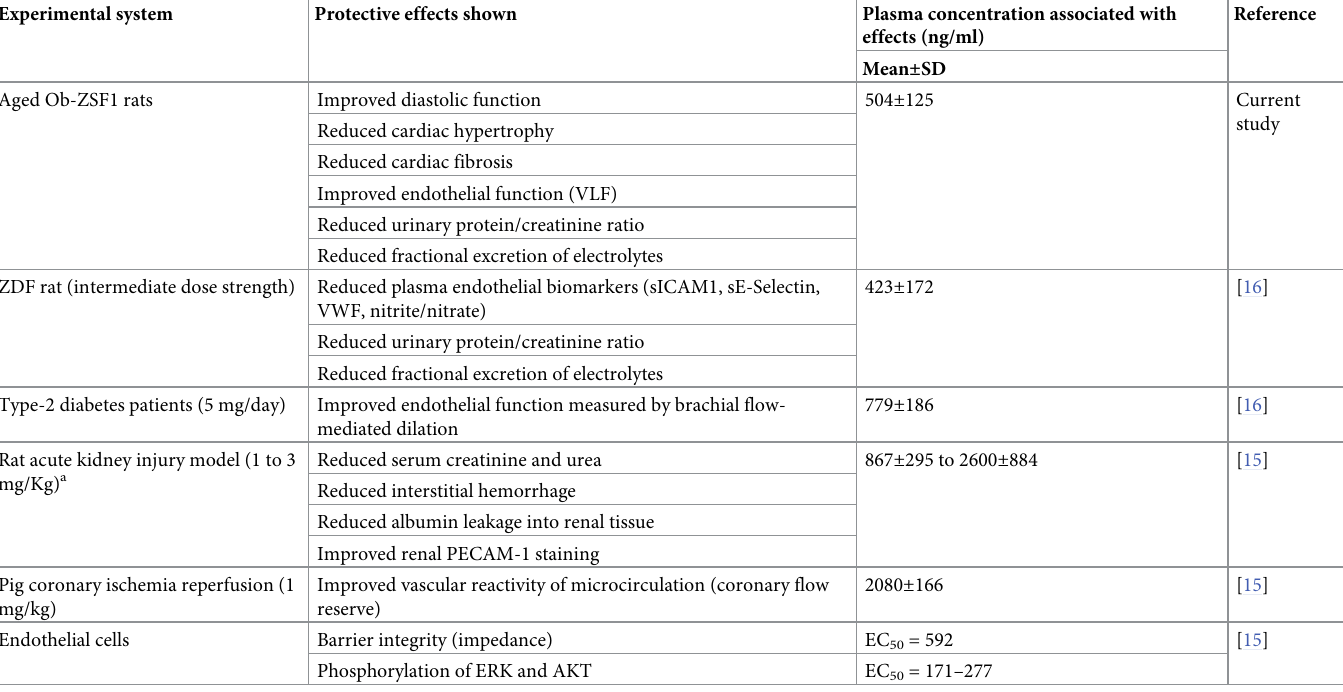
Table 2. Comparison of the protective effects of SAR247799 in aged obese ZSF1 rats with effects seen in prior experimental systems. Experimental system Protective effects shown Plasma concentration associated with